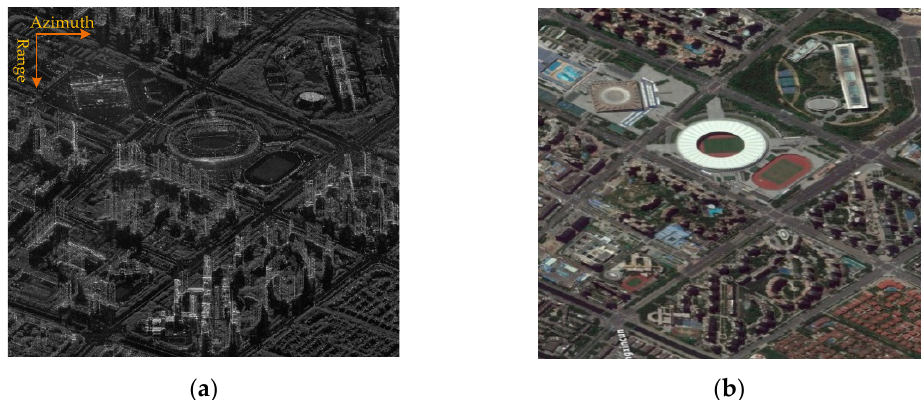
Figure 5. ( a ) The mean calibrated intensity image of the test site; ( b ) the Google Earth snapshot of the